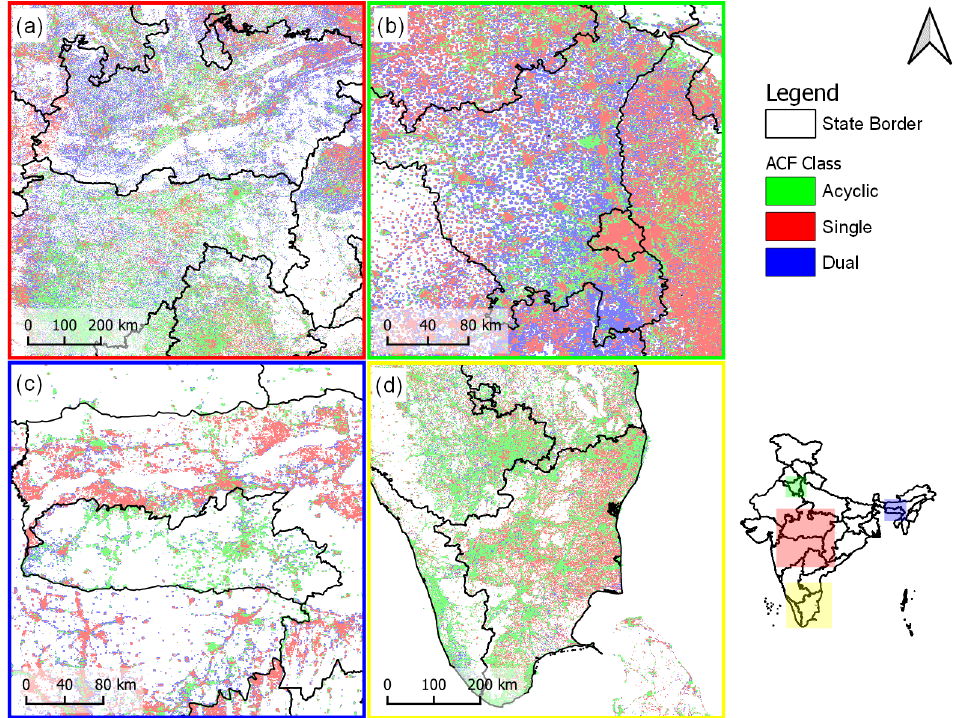
Figure 23. Regions with the supervised ACF classification result of interest. Lit area mask applied. ( a ) Madhya Pradesh and Maharashtra. ( b ) Haryana and neighboring states. ( c ) Meghalaya and Assam. ( d ) Tamil Nadu and neighboring